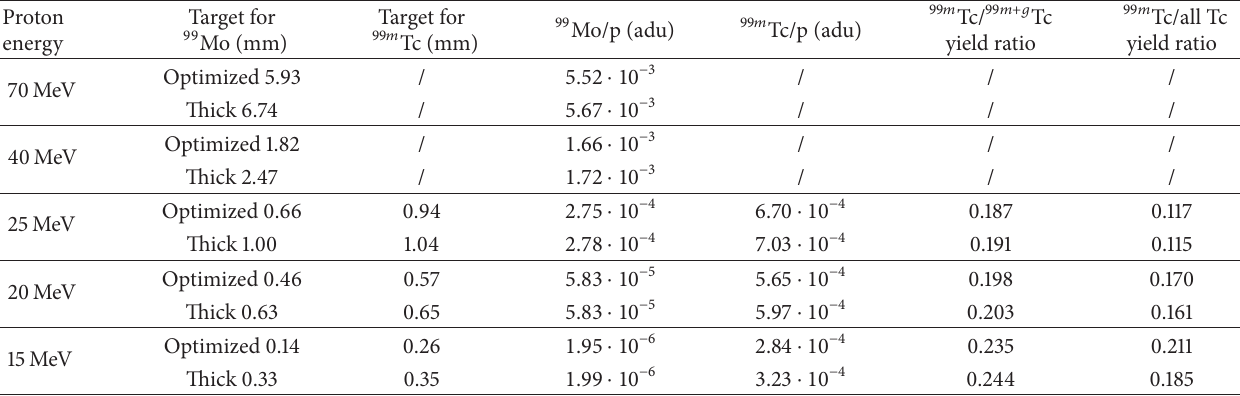
Table 2: The integral production yields (normalized per incident proton) estimated on 100 Mo-enriched sample thicknesses both for 99 Mo and 99𝑚 Tc productions. Additional production quality parameters for 99𝑚 Tc are listed as well.